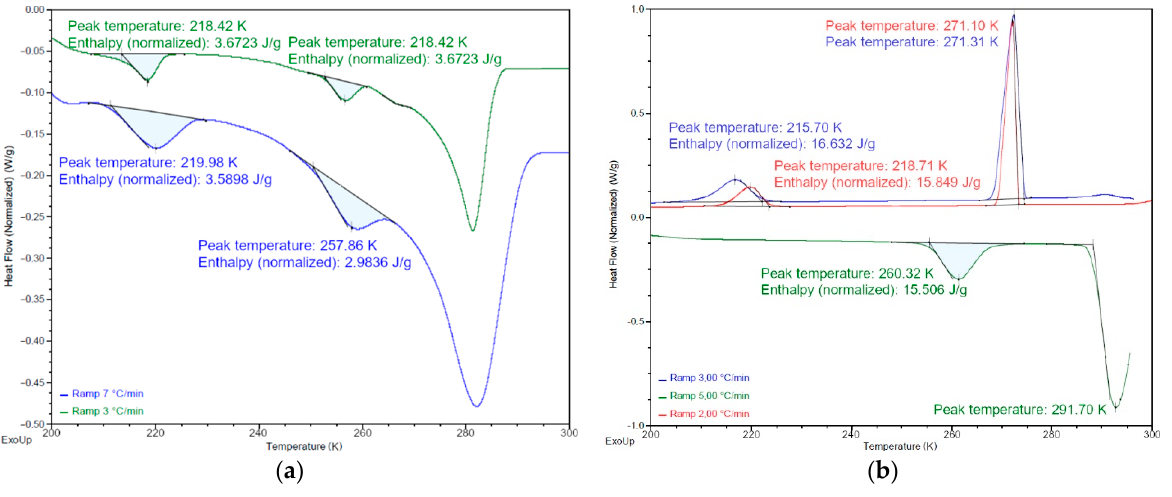
Figure 5. Differential scanning calorimetry data of impure ( a ) (98%) and pure ( b ) (>99.5%) D4